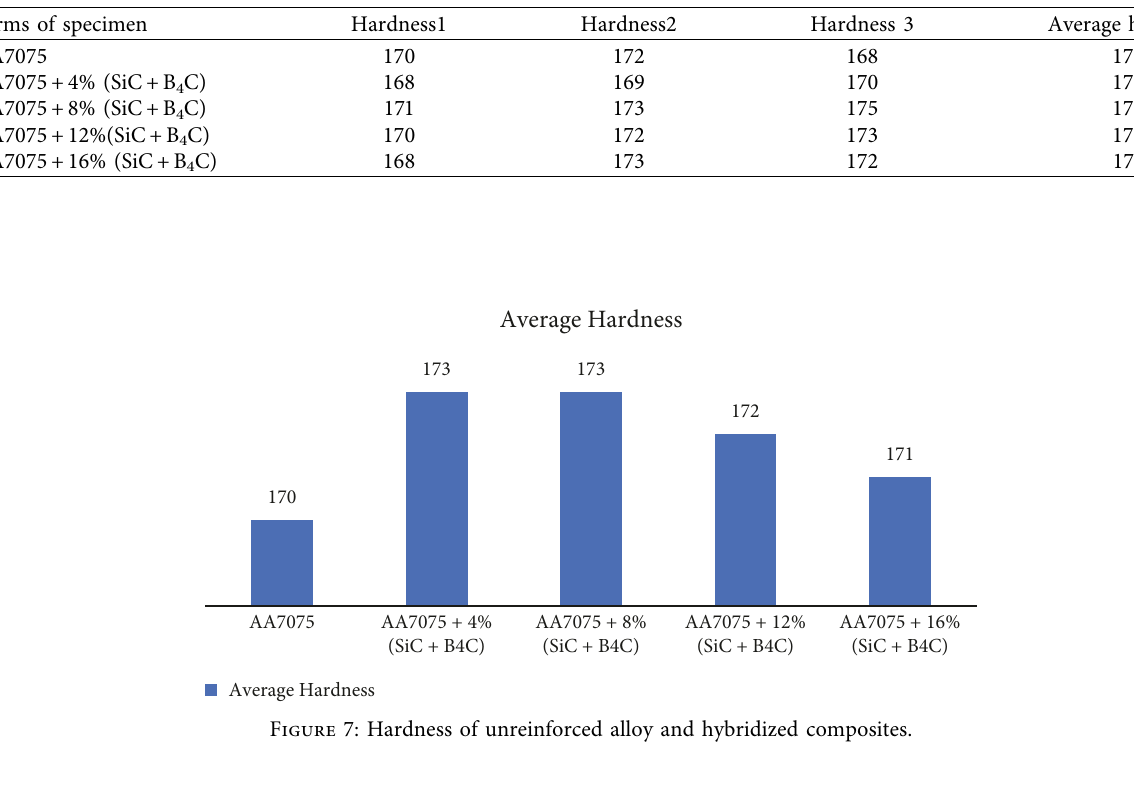
Table 4: Results on microhardness.